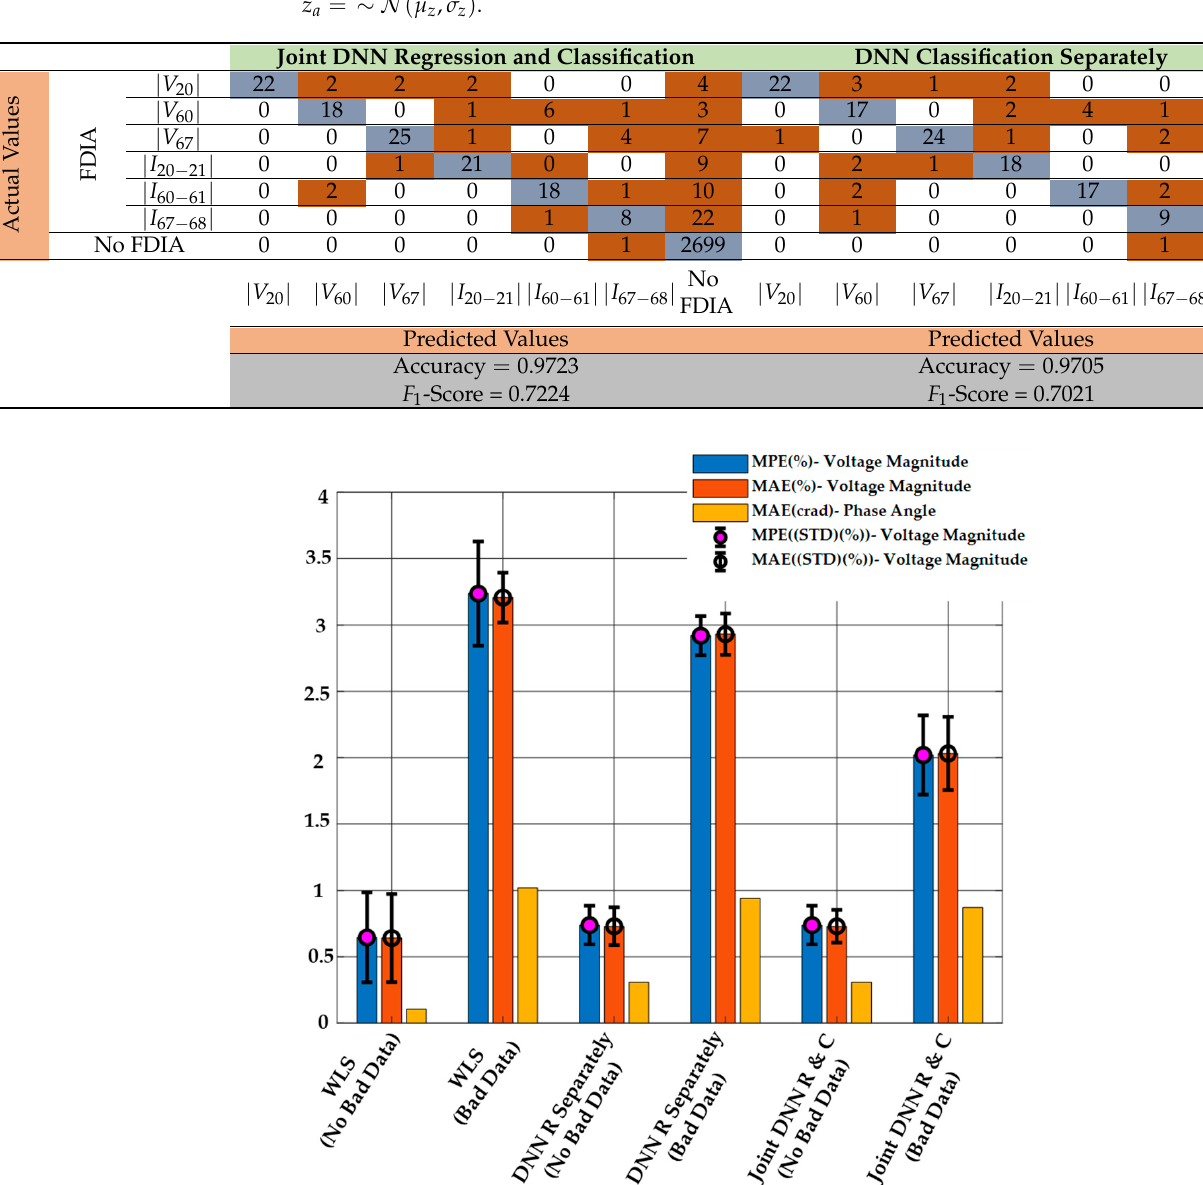
Table 6. Confusion Matrix Showing Bad Data Detection Results and Accuracy Values Obtained Using the Proposed Method and the Binary Classification-only DNN Model when N a = 438 ( 5% ) , and z a = ∼ N ( µ z , σ z ) .